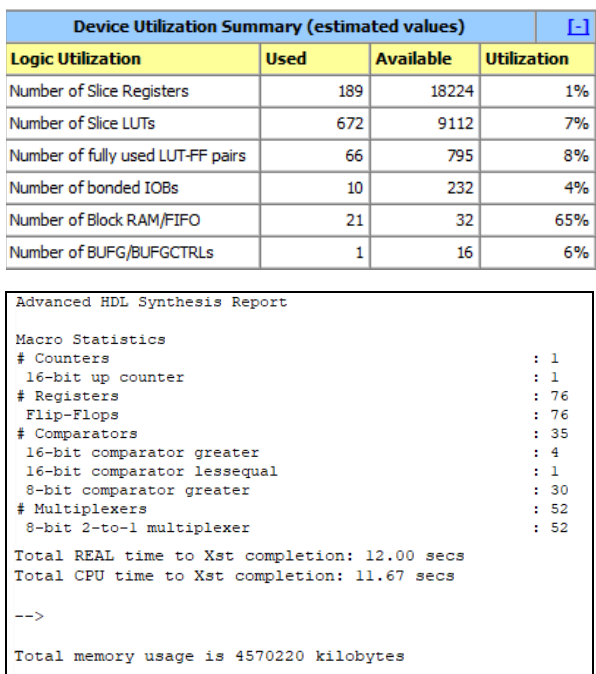
Table 1. Summary report after synthesis